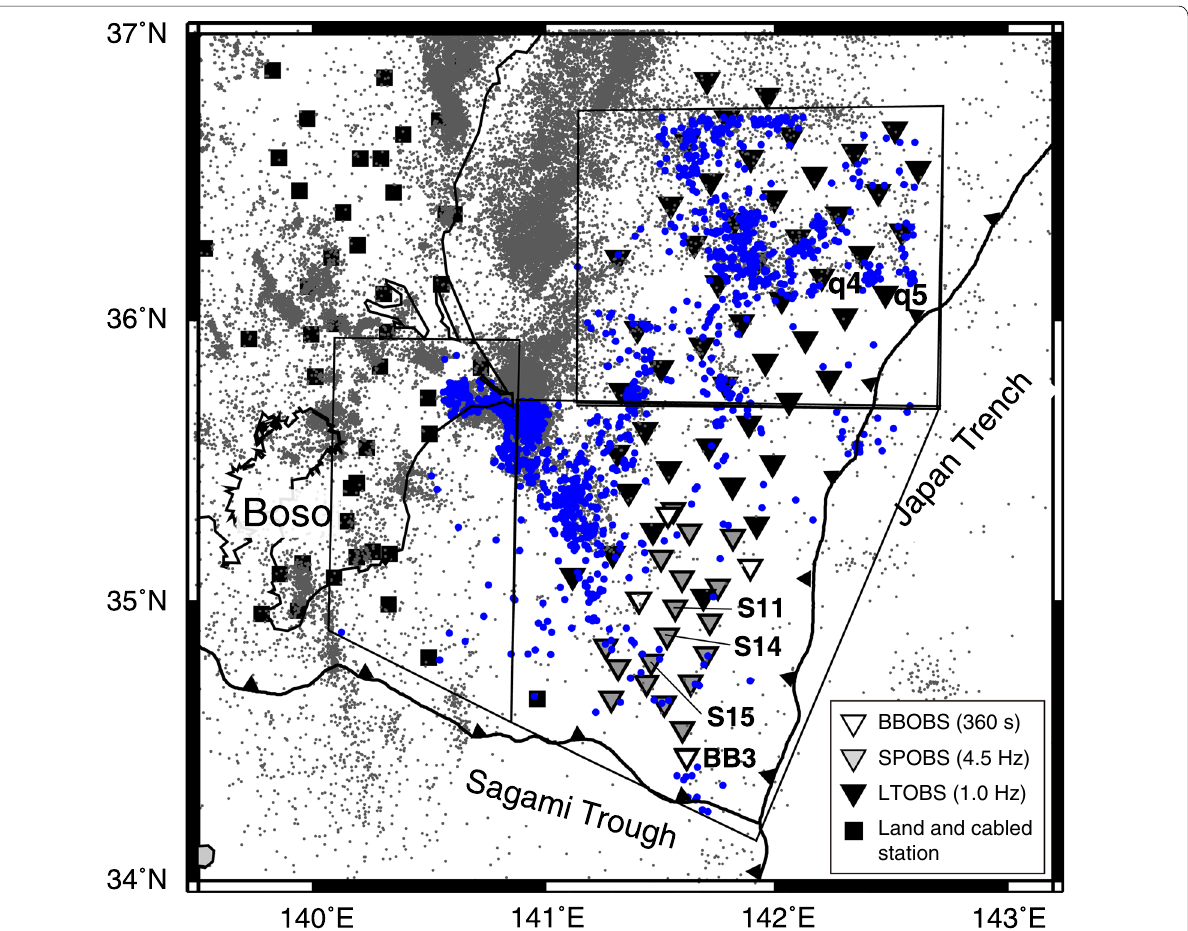
Fig. 2 Locations of the earthquakes and seismic stations used in this study. Small gray dots indicate earthquake epicenters as determined by JMA between October 2011 and March 2013. Blue dots indicate the earthquake epicenters analyzed in this study. The earthquake selection areas are delineated by black lines. White, gray, and black triangles indicate BBOBSs, SPOBSs, and LTOBSs, respectively. Black squares indicate NIED stations